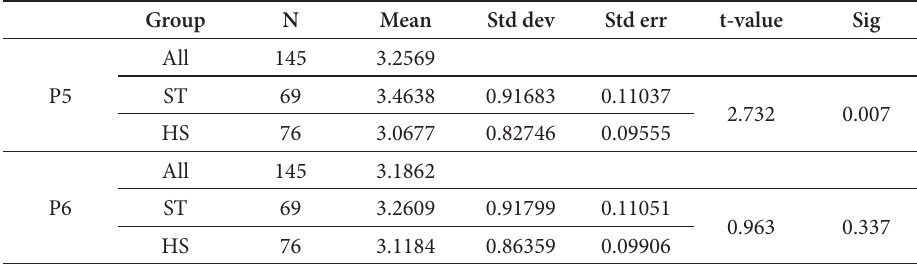
Table 6. Acceptance and tolerance for knowledge in other domains Group